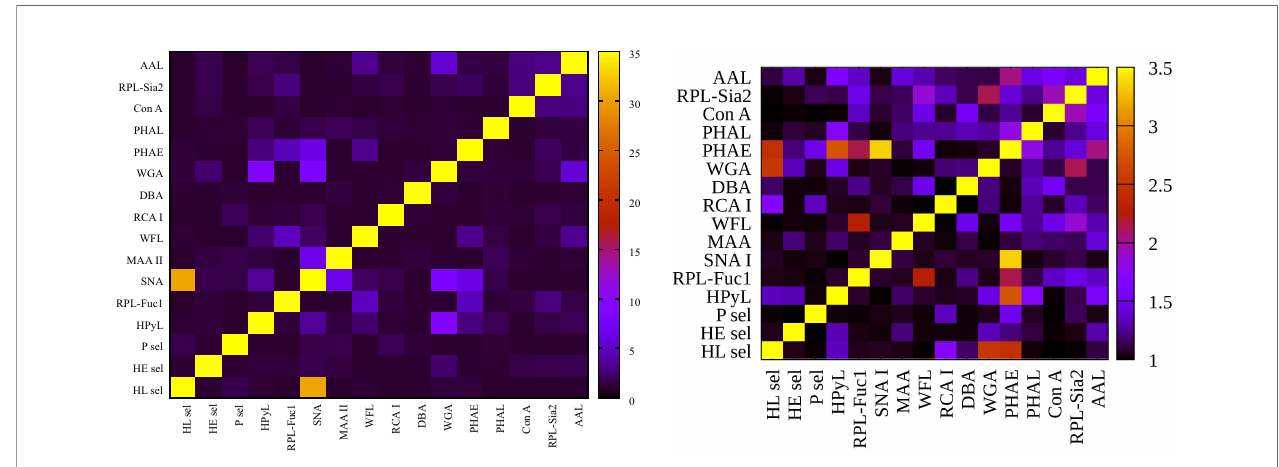
lectins by an additional statistical evaluation ( Figure 3 right and Figure 4 right ). The lectin combination PHAE + HL sel provided the highest discrimination accuracy based on the AUC value (0.989).